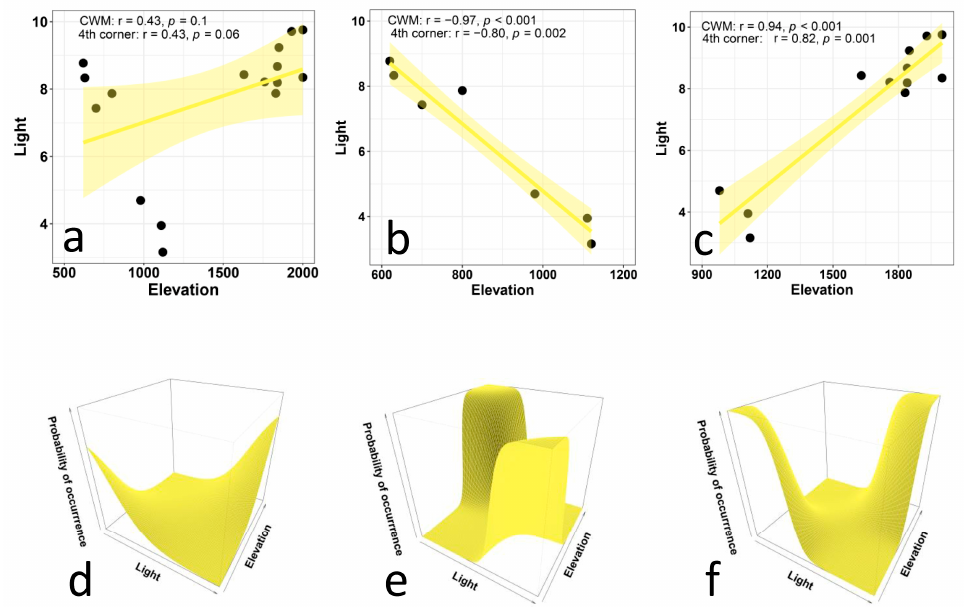
Figure 2. Relationship between Ellenberg indicator values for light and elevation in plant communities along an elevational gradient in Central Italy. The upper panels ( a – d ) present CWM regression models and their statistical corrections using fourth-corner analysis for the entire gradient ( a ), for the lower subgradient ( b ), and for the upper subgradient ( c ). The lower panels ( d – f ) illustrate the results of multi-level models for the entire gradient ( d , trait × environment interaction p < 0.001, marginal R 2 = 0.03), for the lower subgradient ( e , trait × environment interaction p < 0.001, marginal R 2 = 0.26), and for the upper subgradient ( f , trait × environment interaction p < 0.001, marginal R 2 = 0.32).